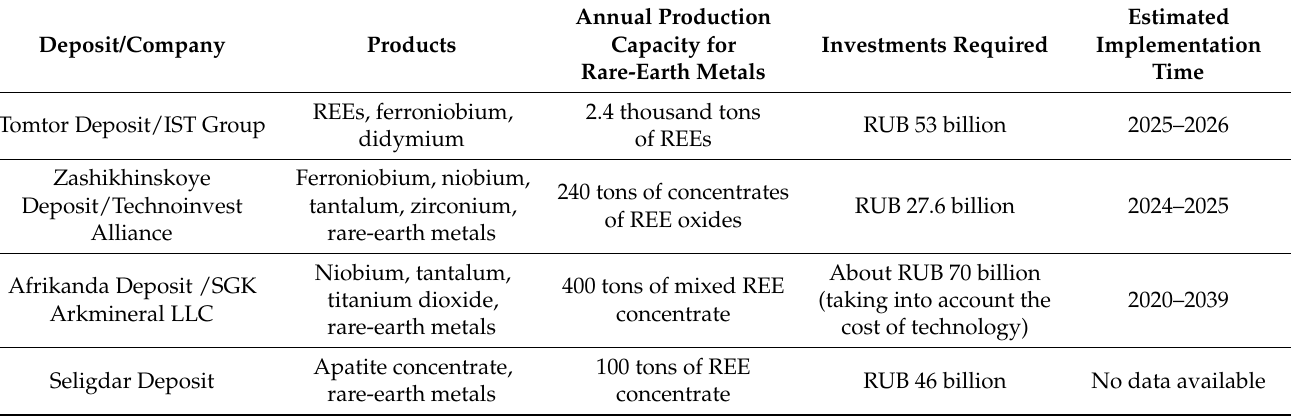
Table 3. The key characteristics of prospective REM projects in